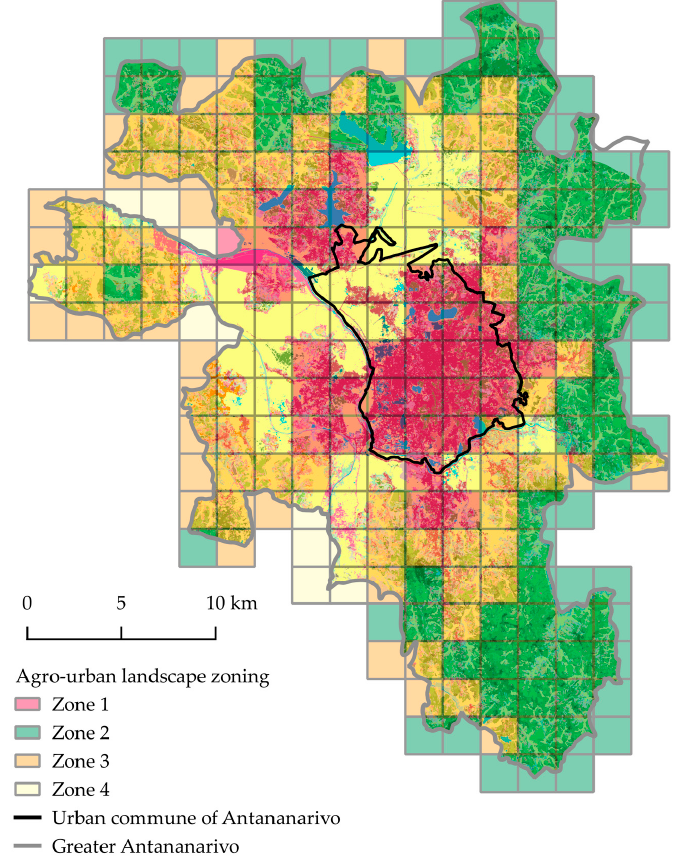
Figure 6. Agri-urban landscapes zoning of Great Antananarivo (background: land cover map at level 3—crop class, see Figure 3—crop class, see Figure 5).